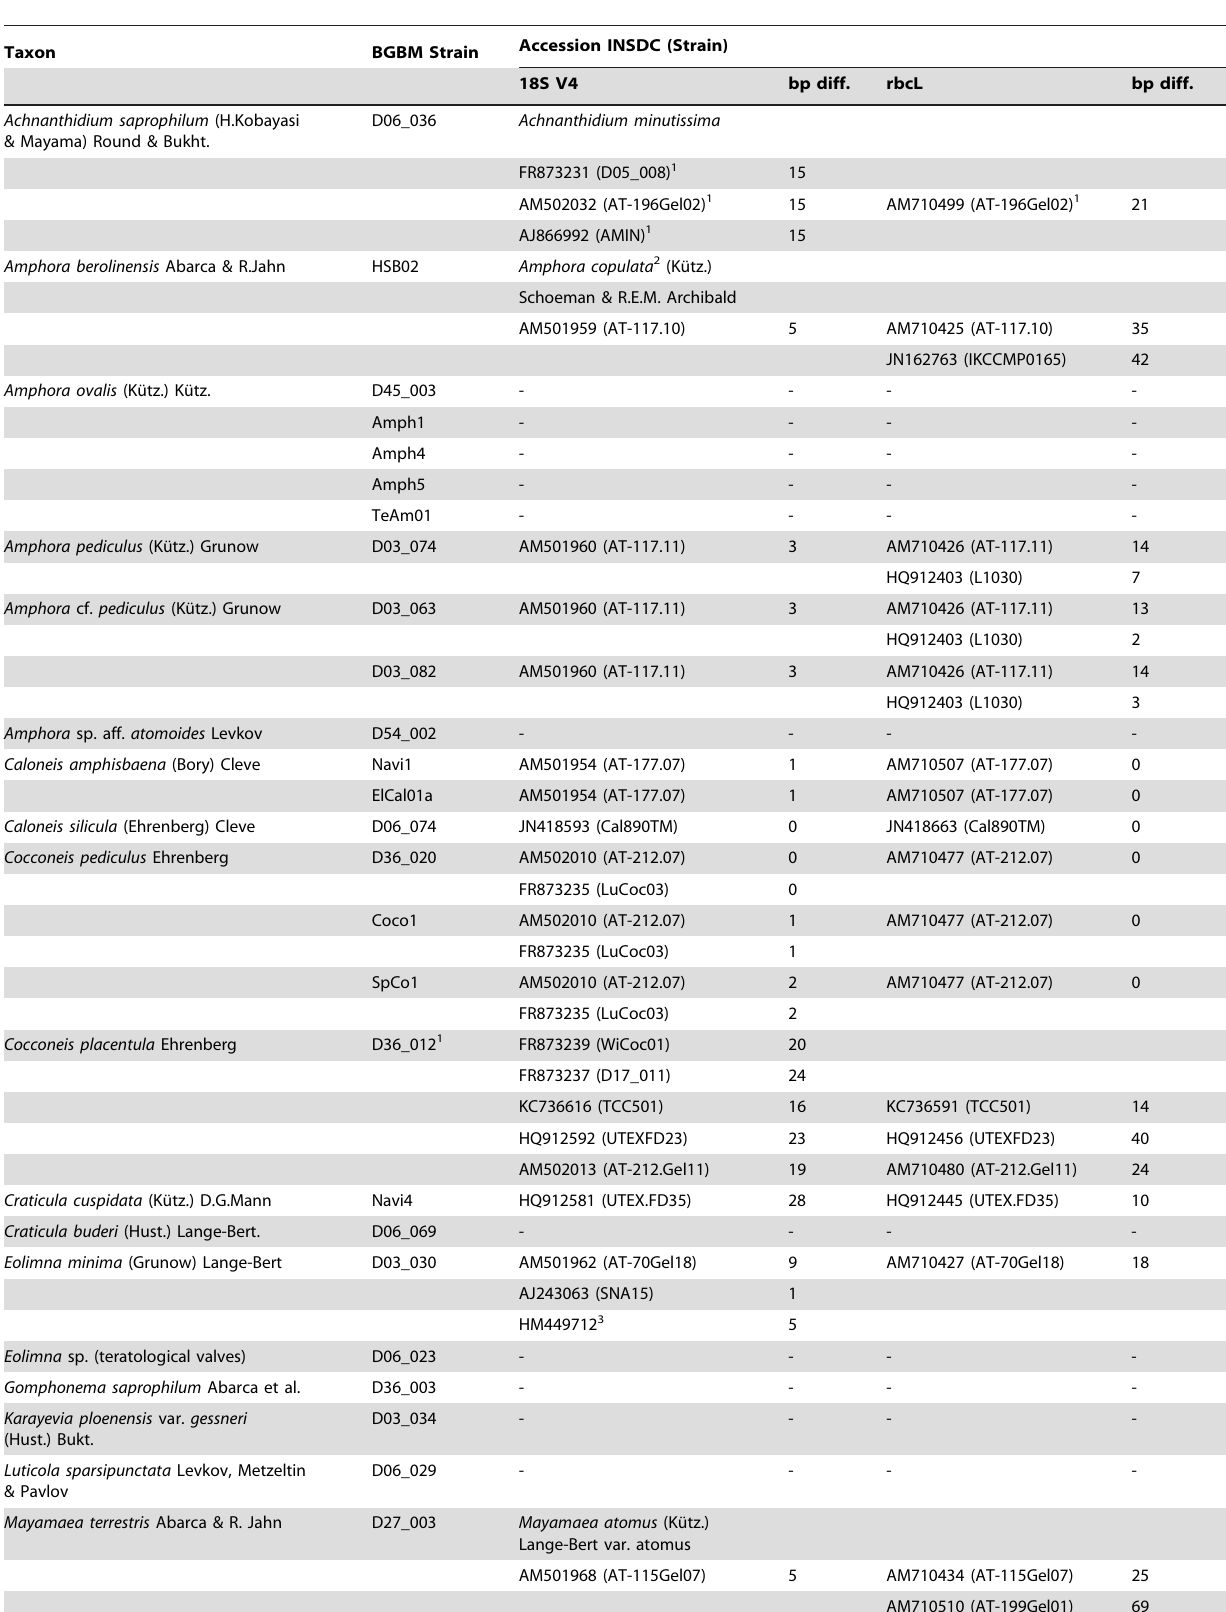
Table 3. Sequence comparison of the here presented strains with corresponding accessions from INSDC databases.